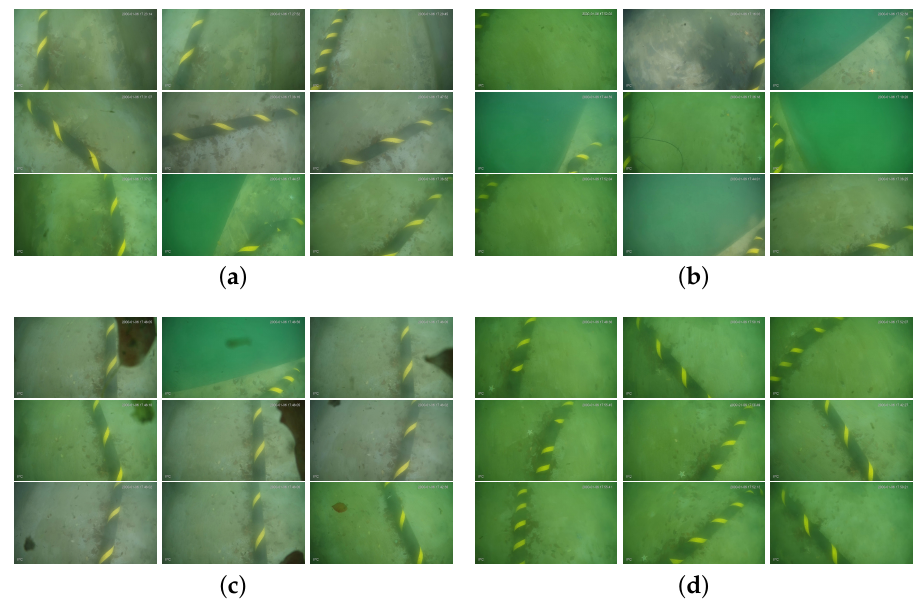
Figure 11. Sample of submarine cable dataset under different disturbances: ( a ) motion blur, ( b ) partial absence, ( c ) occlusion, ( d ) absorption and scattering effects of water on light.